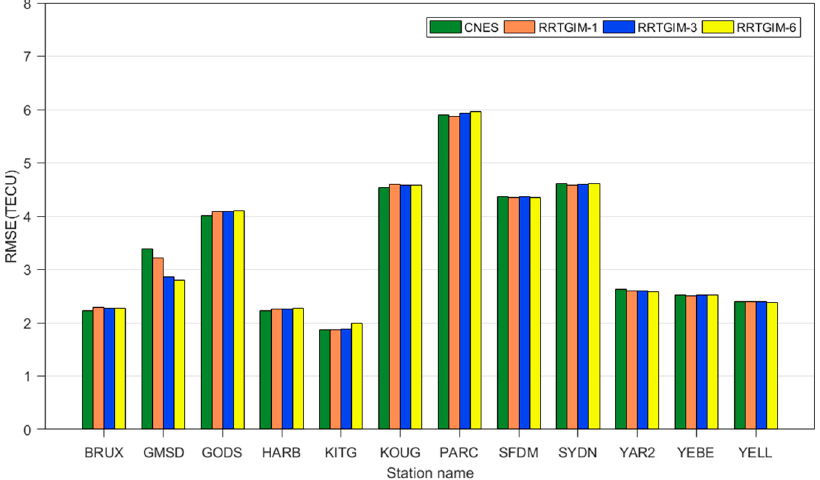
Figure 14. STEC RMSE of the 12 global stations on DOY 78,2 April 2020 Comparison with VTEC derived from Jason-3.